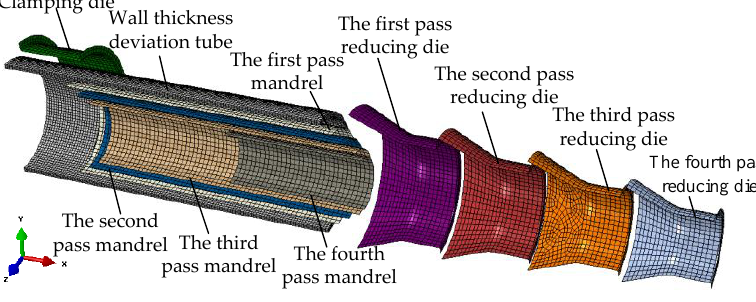
Figure 26. Finite element model.